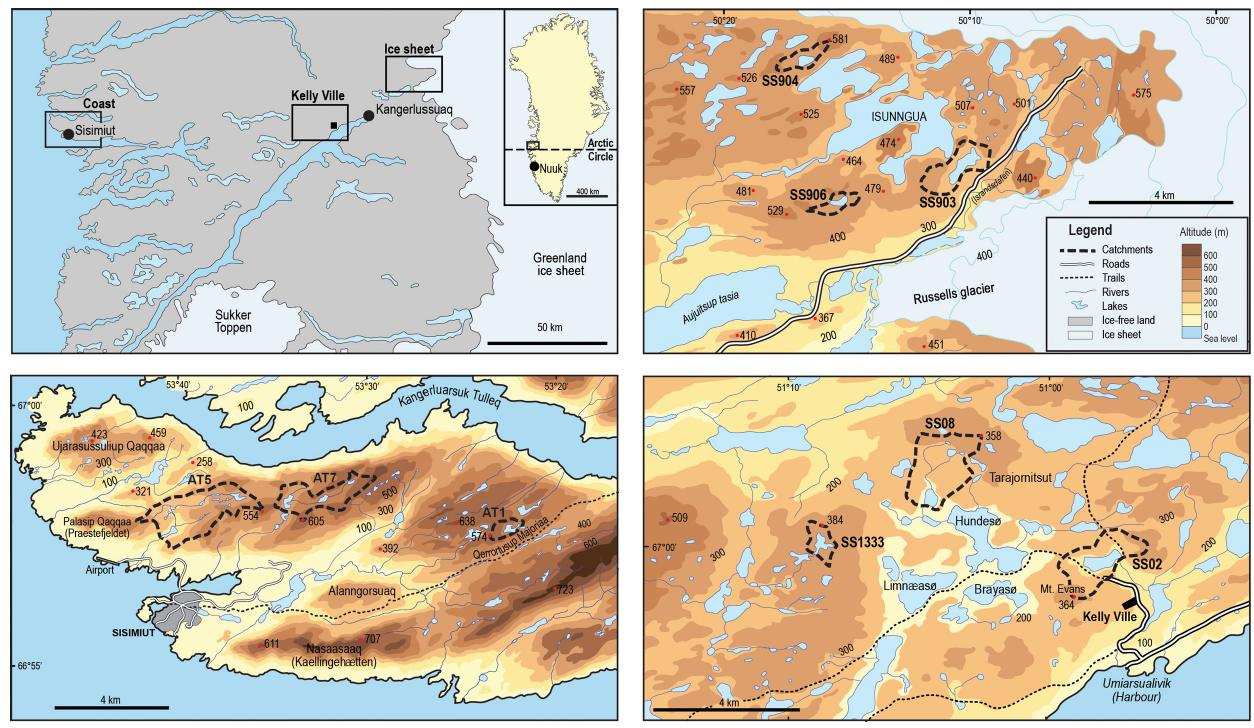
Figure 1. Location of sampling regions and catchments within western